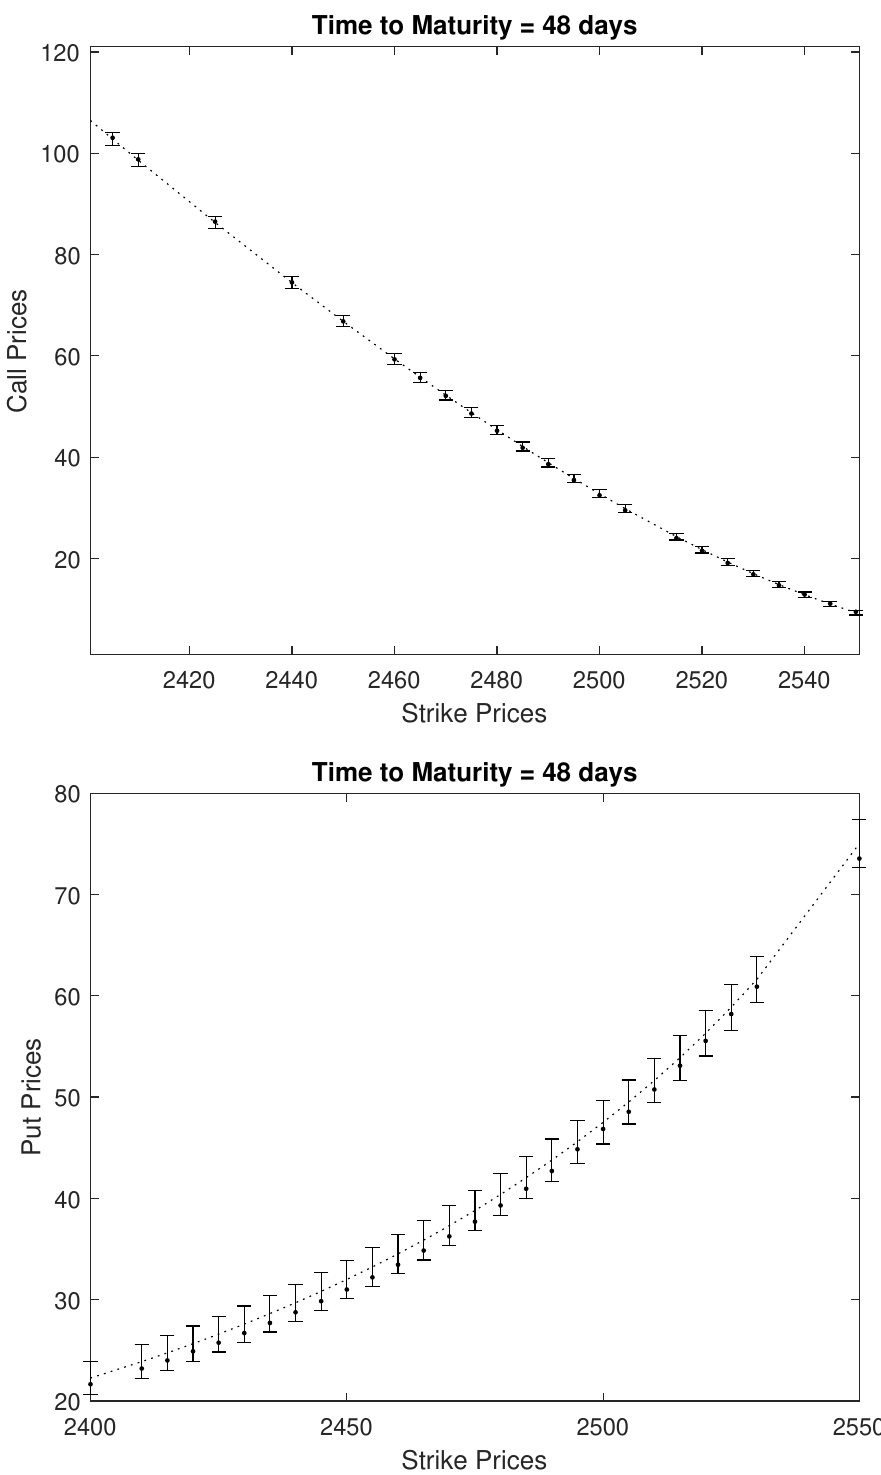
Figure 4. Confidence Intervals for the MCS option prices. Dots are observed market prices, dot-coves are MCS prices, and ‘I’ shape bars are 95% confidence intervals of MCS prices. The first ( top ) plate is for call option pricing and the second ( bottom ) plate is for put option